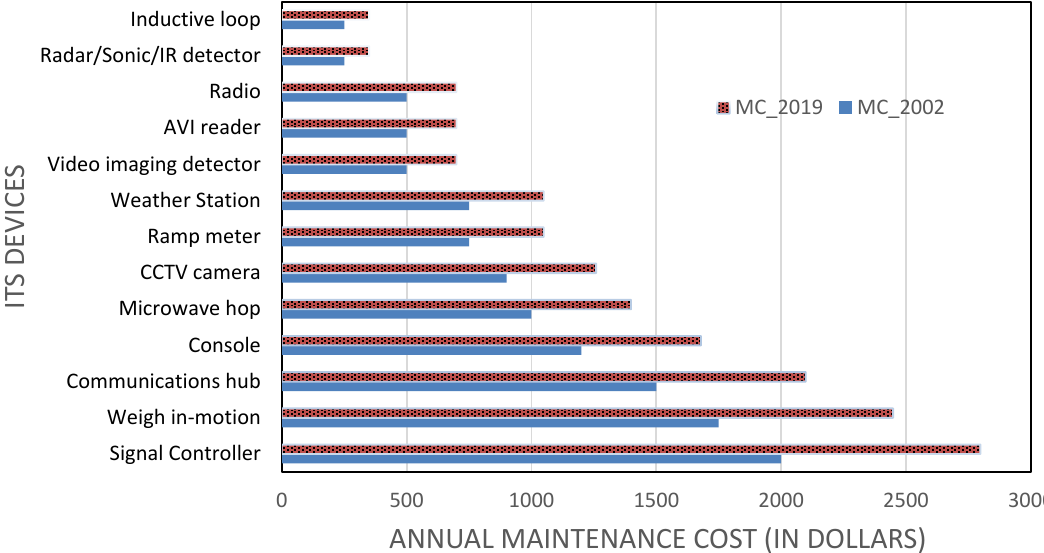
Figure 1. Annual maintenance costs for ITS devices. NB: 2019 maintenance costs obtained based on data from Vick and Sumner [9] and inflation rate for the year 2019; MC is the maintenance cost.